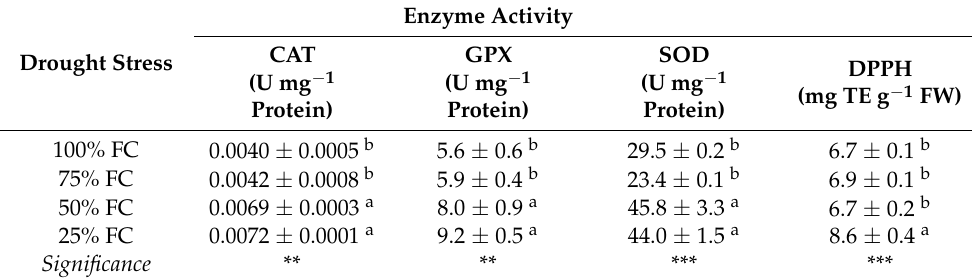
Figure 5. Proline content ( a ) and malondialdehyde content (MDA) ( b ) in zinnia plants. Plants were irrigated at field capacity (100% FC) or subjected to drought stress (75% FC, 50% FC, and 25% FC). Mean values ± standard error (S.E) (n = 6). Different letters indicate significant differences among the treatments as determined by Tukey’s test. ns: no significant. Table 4. Effects of irrigation treatments on catalase (CAT), peroxidase (GPX), and superoxide dismu- tase (SOD) activity of potted zinnia plants at the end of the experimental period. Plants were irrigated every day. Four treatments were performed: irrigated at 100% (100% FC), light deficit irrigation (75% FC), irrigated at 75% from the 100% FC treatment; medium deficit irrigation (50% FC), irrigated at 50% from the 100% FC treatment and severe deficit irrigation (25% FC), irrigated at 25% from the 100% FC treatment.